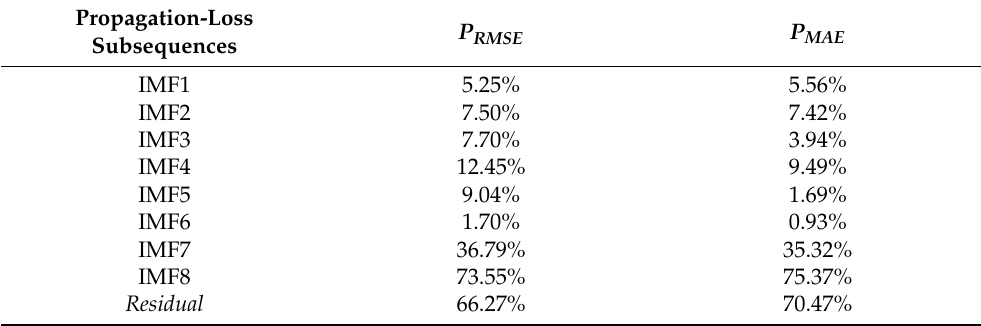
Table 10. Percentage improvement in propagation-loss subsequences prediction capability by GA (surface duct).